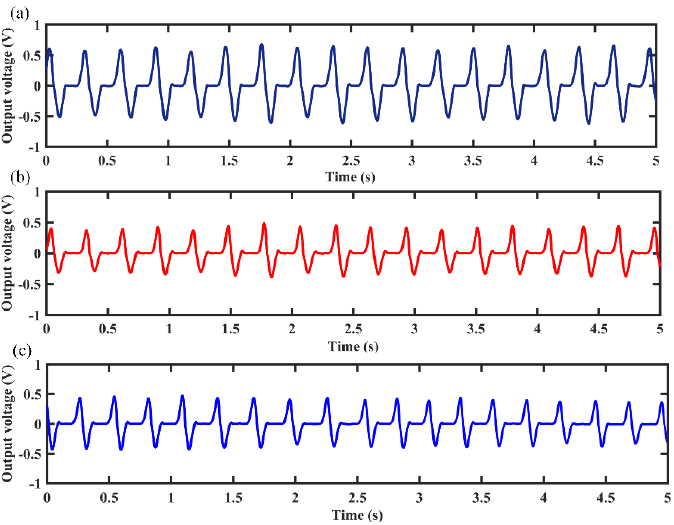
Figure 12. Electrical output under hand-held excitation: ( a ) output voltage of coil 1; ( b ) output voltage of coil 2; ( c ) output voltage of coil 3.